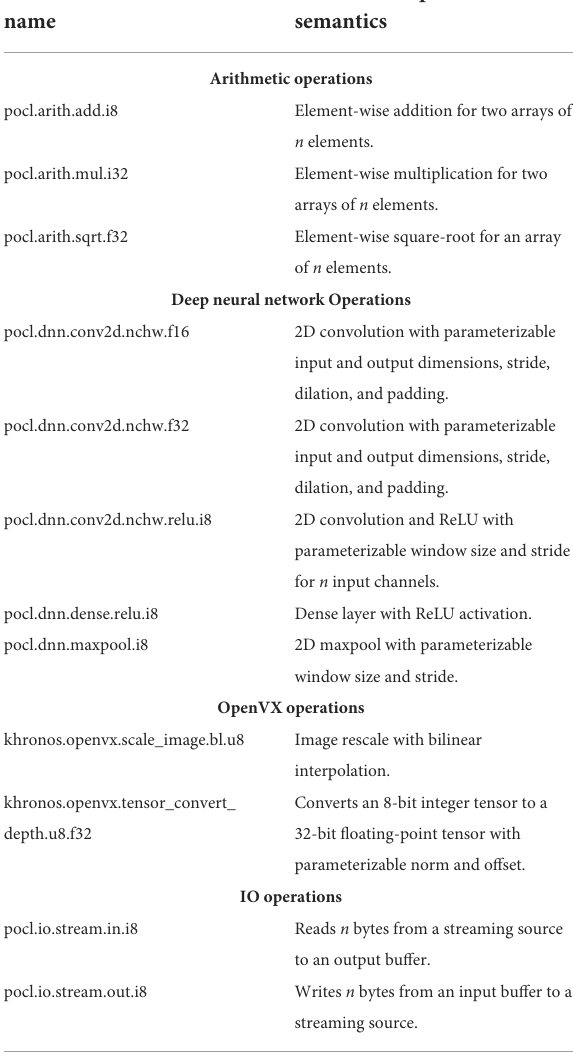
TABLE 1 Example snippet of a built-in kernel registry.